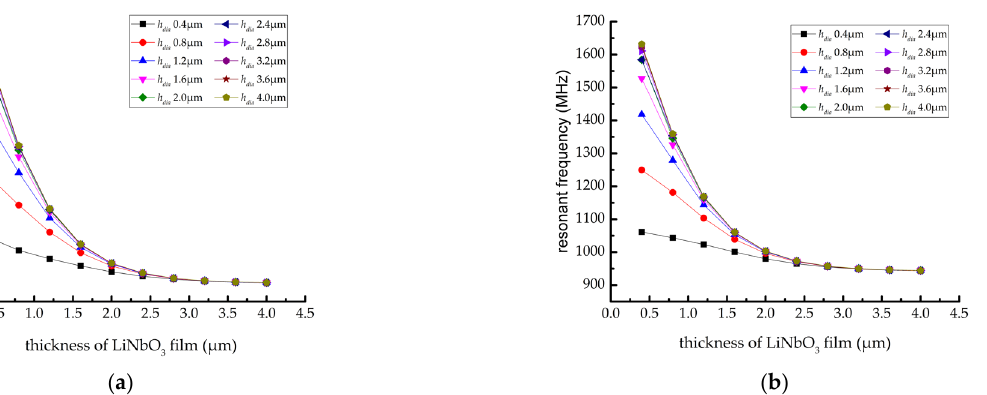
Figure 7. Distribution curve of electromechanical coupling coefficient K 2.